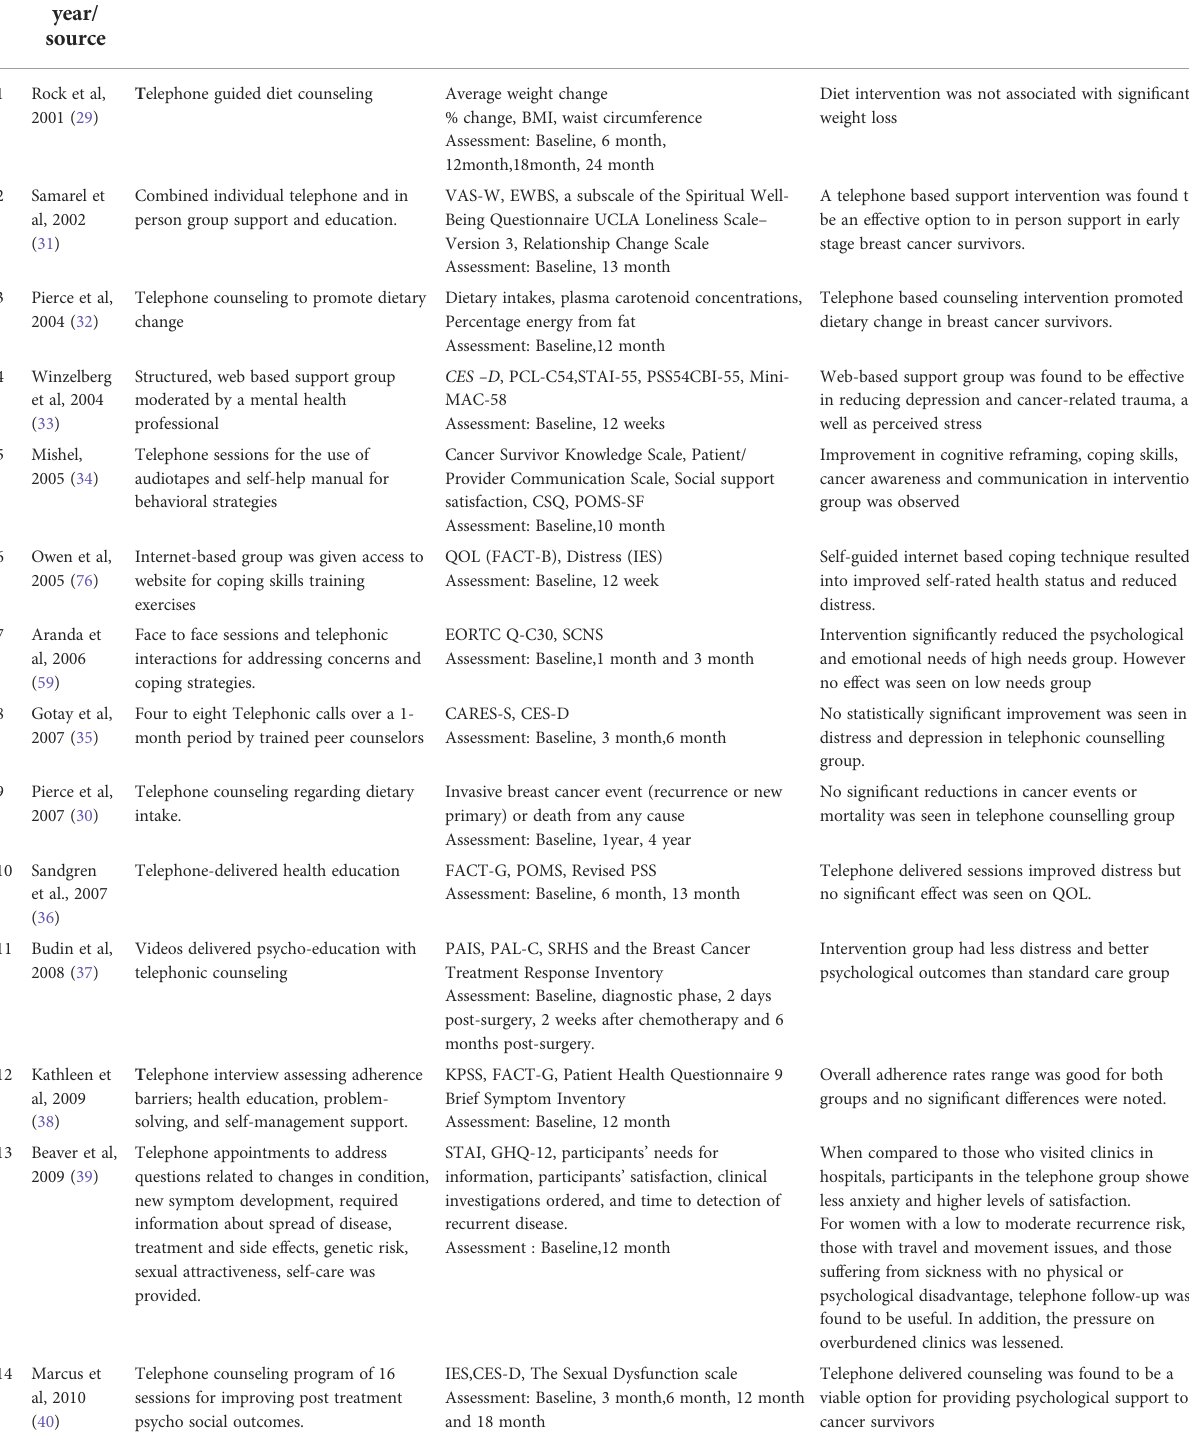
TABLE 3 Interventions, outcome measures and results of included